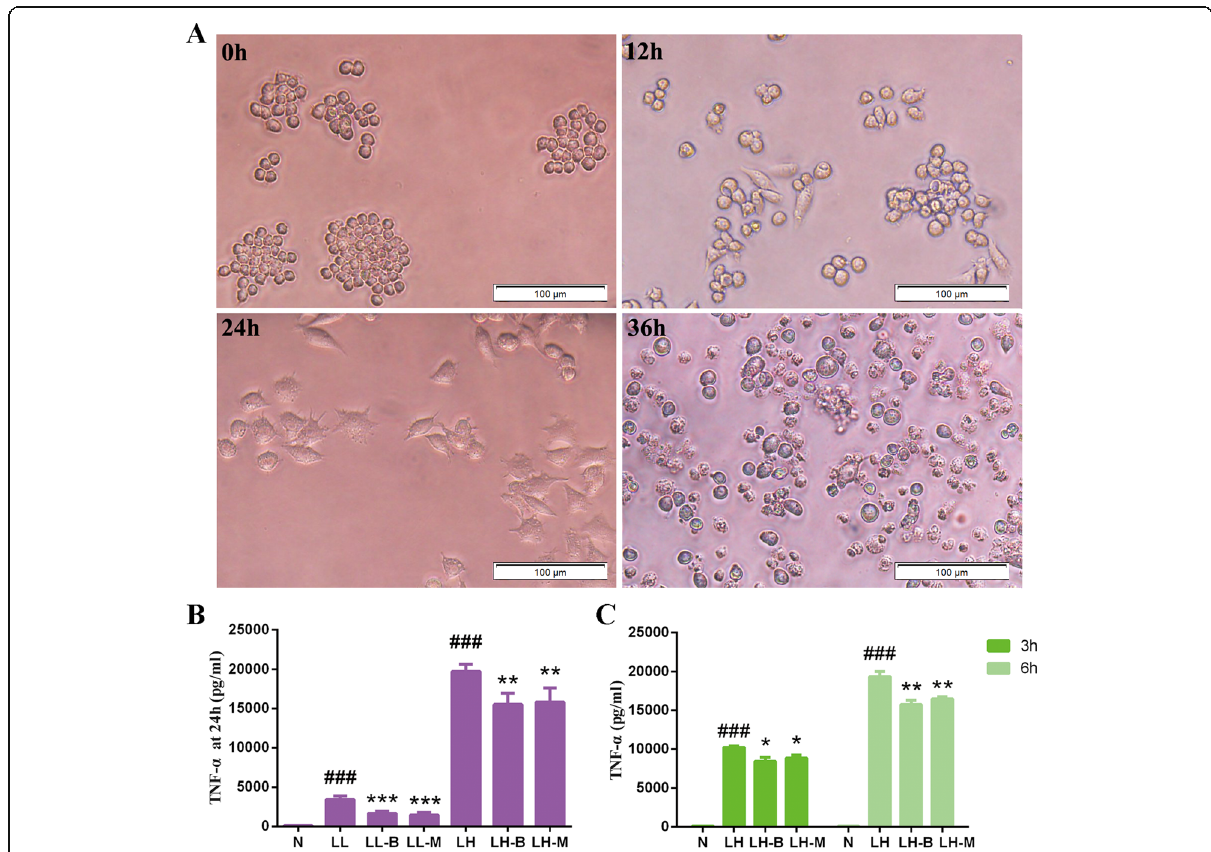
Fig. 4 Morphological changes after high-dose LPS intervention ( a ) and the effects of BBR on LPS-induced TNF- α secretion ( b - c ) in Raw264.7 cells at different times. N, control group; LL, 0.1 μ M LPS group; LL-B, 0.1 μ M LPS+BBR group; LL-M, 0.1 μ M LPS+Metformin group; LH, 0.1mM LPS group; LH-B, 0.1mM LPS+ BBR group; LH-M, 0.1 μ M LPS+Metformin group. Compared with control group, ### P <0.001; Compared with LL or LH group, * P <0.05, ** P <0.01, *** P